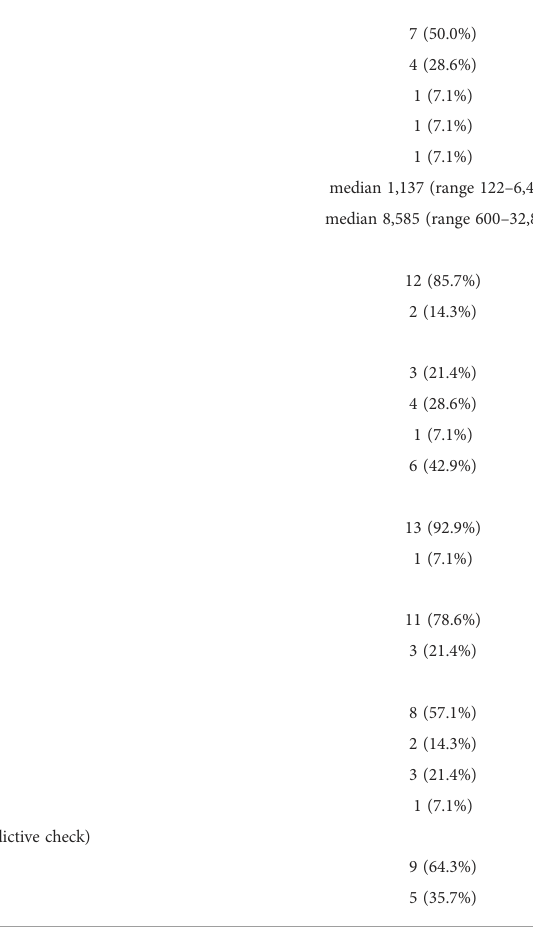
Supplementary Figure 1. The proportional residual error